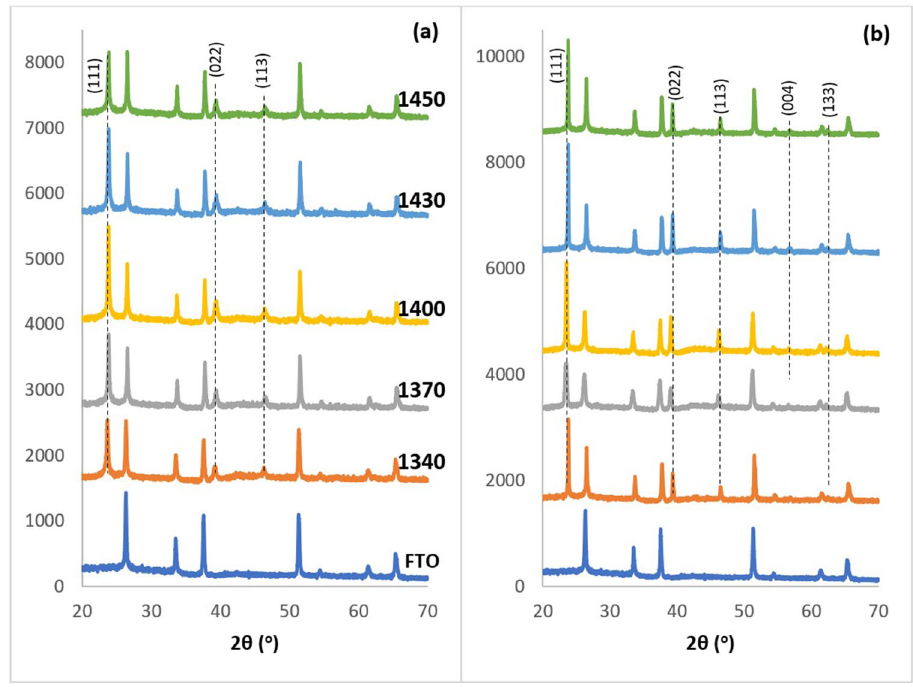
Figure 3. XRD patterns of (a) as-deposited and (b) CdCl 2 treated CdMnTe thin film layers grown at V g range from 1340 to 1450